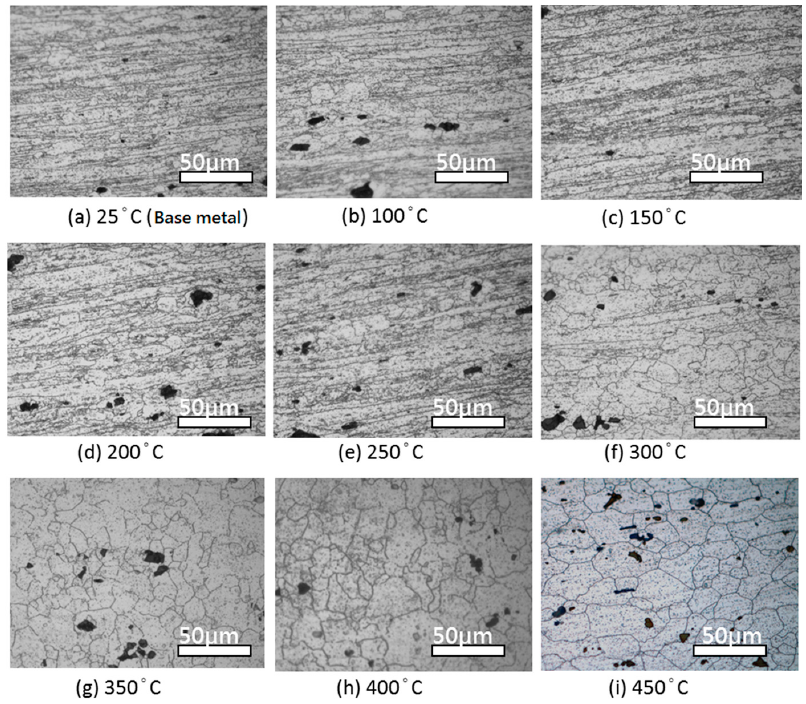
Figure 3. OM images of 5383-H116 Al-Mg alloy β -phase precipitation at different annealing temperatures after 175 °C/168 h sensitization. ( a ) 25 °C; ( b ) 100 °C; ( c ) 150 °C; ( d ) 200 °C; ( e ) 250 °C; ( f ) 300 °C; ( g ) 350 °C; ( h ) 400 °C; ( i ) 450 °C.